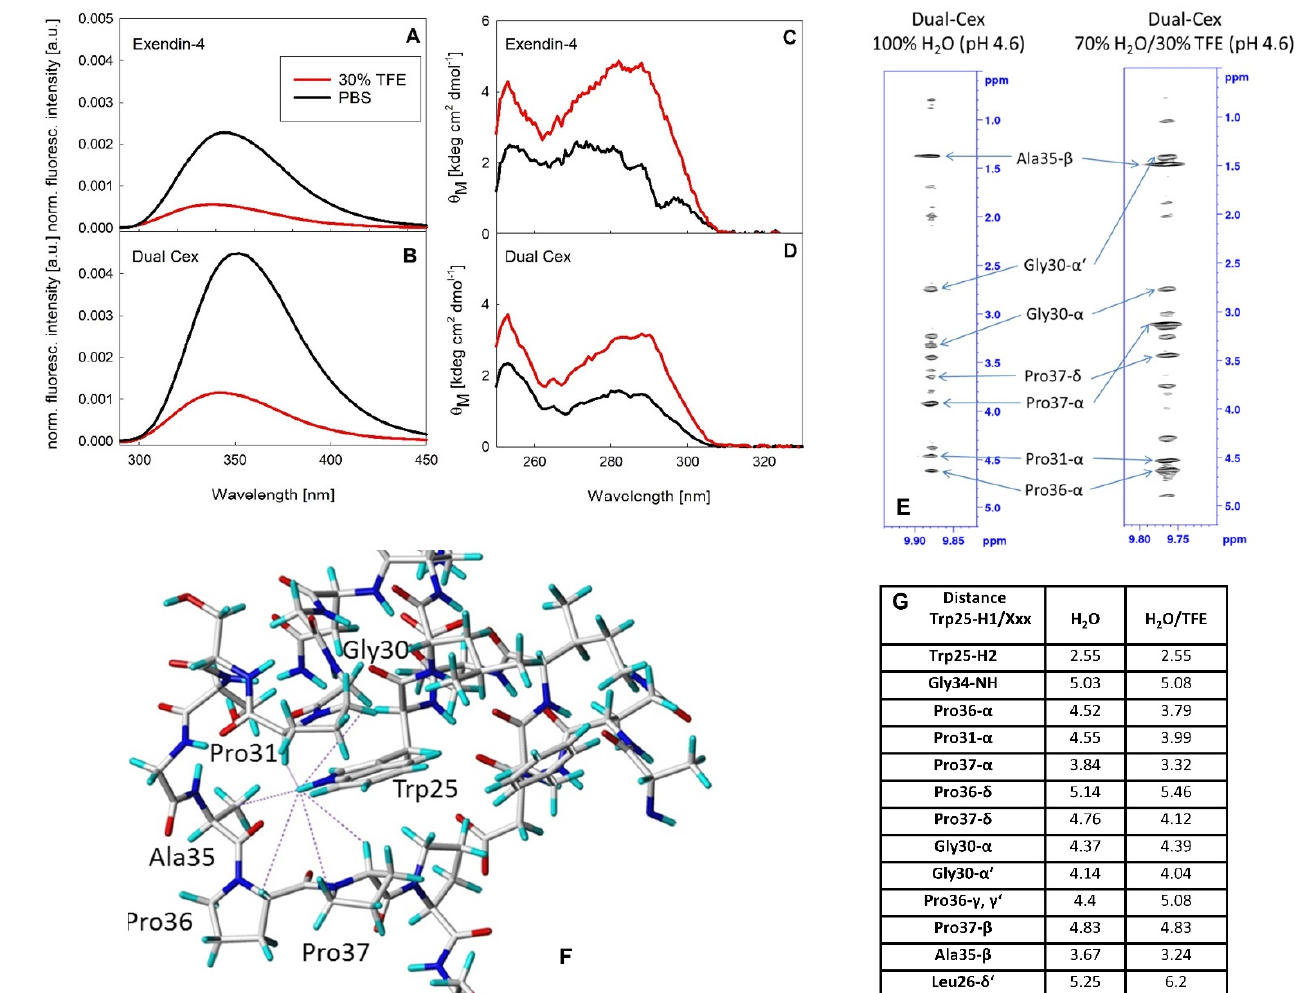
Figure 9. Spectral signatures of exendin-4 and Dual-Cex in PBS and 30% TFE. Normalized Trp fluorescence ( A , B ) and near-UV CD ( C , D ) spectra of exendin-4 ( A , C ) and Dual-Cex ( B , D ) in PBS and PBS + 30% TFE. Regions of the NOESY spectra of Dual-Cex in water and in 30% TFE illustrating NOEs between Trp25-H1 and protons of residues involved in the formation of the Trp-cage (Gly30, Pro31, Ala35, Pro36, Pro37) ( E ). Interproton distances (illustrated as dashed lines in ( F ); grey, red, blue and light blue colors represent carbon, oxygen, nitrogen and hydrogen atoms, respectively) were obtained by integration of the NOESY peaks using the distance between Trp25-H1 and Trp25-H2 as reference peak (distance was set to 2.55 Å) ( G ).